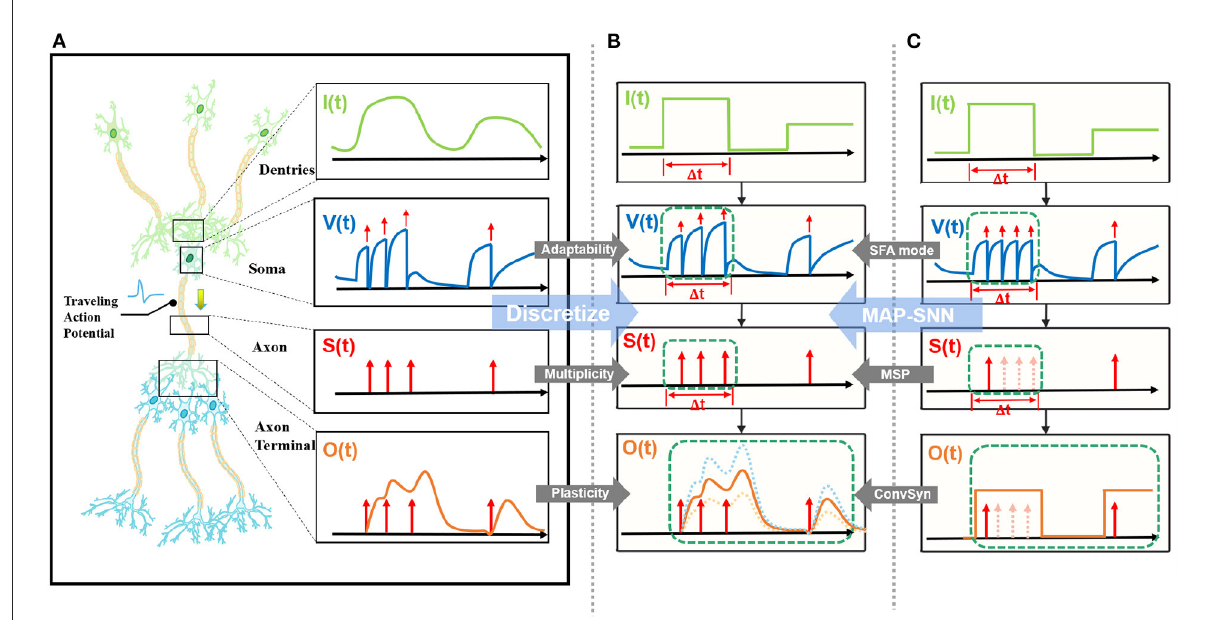
FIGURE1 MAP-SNN overview. (A) Modeling neural model mathematically with Dendrites, Soma and Axon. The four variables I , V , S , and O describe the input current, the membrane potential, the spike transmission, and the output current concerning time, respectively. (B) MAP-SNN: Discretized spike activities with MAP properties. (C) Discretized spike activities without proposed